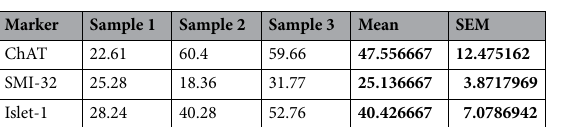
Table 1. Average of the expression level of each marker. Significant values are in [bold].